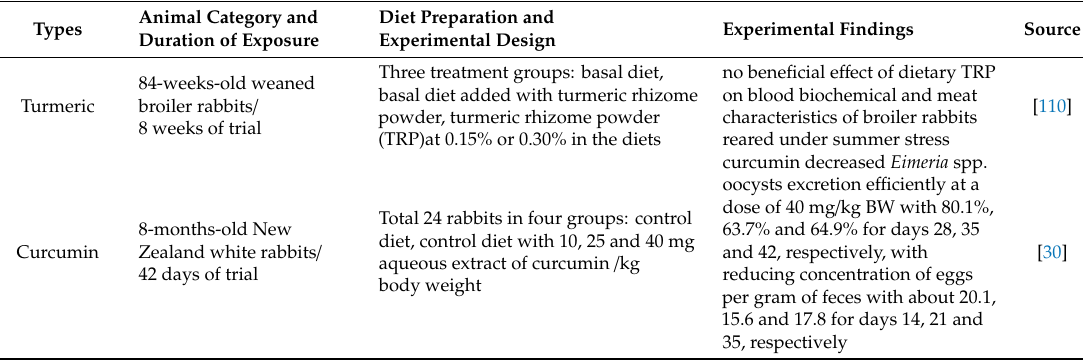
Table 3. E ff ects of dietary turmeric and curcumin in rabbit nutrition.